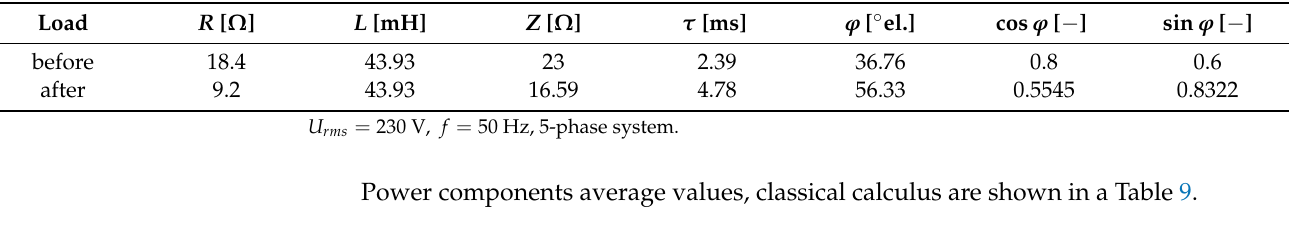
Table 9. Classical calculation before and after the change (at steady states).